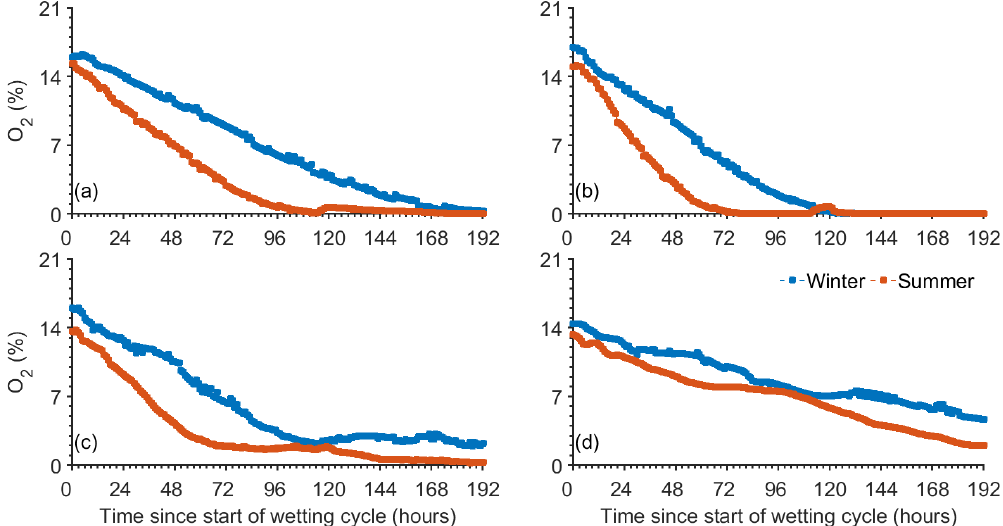
Figure 8. Plot of hourly means of gaseous O 2 measurements from the beginning of the wetting stages at (a) 25, (b) 50, (c) 75, and (d) 150cm depths. The statistics are based on 14 cycles during winter (November–April) and 19 cycles during summer (May–October) that were observed at multiple depths in station 2. Note that the data are separated between summer and winter according to the trends presented in Fig.